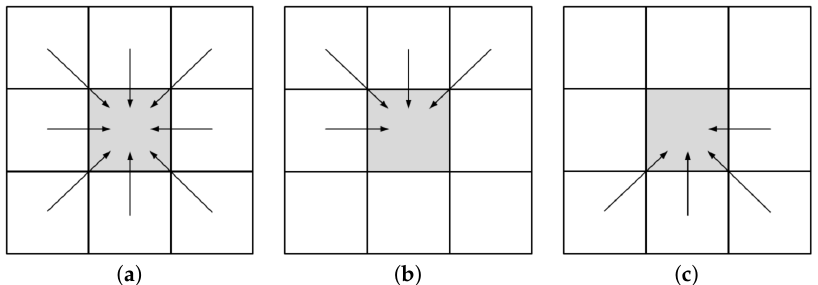
Figure 16. Concept of splitting 8 scanlines spanning the 2D image space ( a ) into 2 passes ( b ) down-right and ( c )